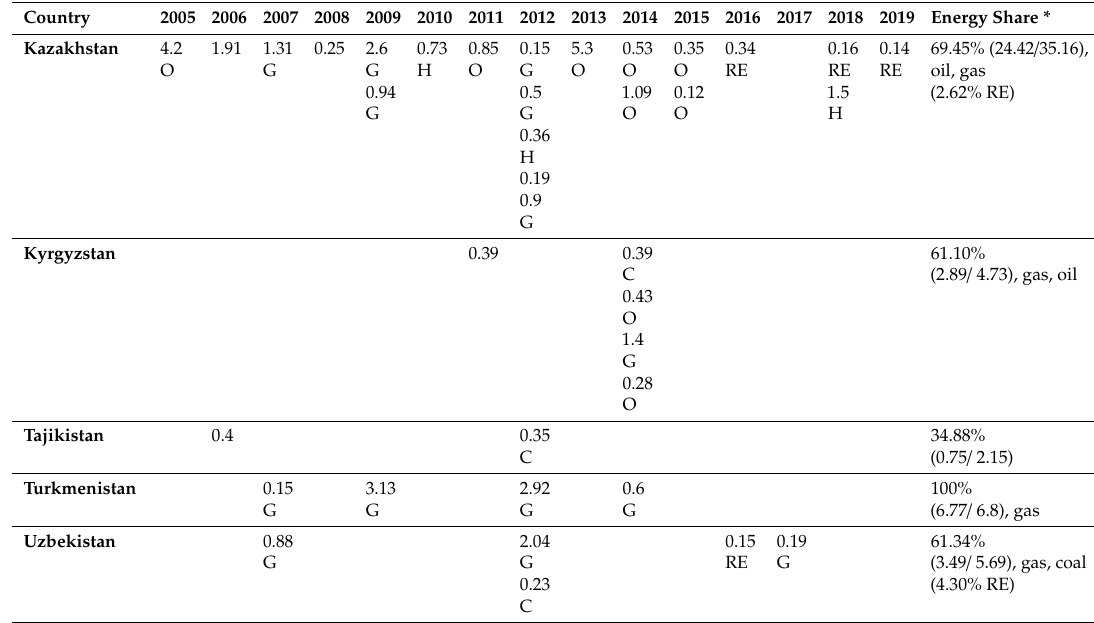
Table A6. China’s Investments in Central Asian Economies’ Energy Sectors, bn US$. (Source: author, based on China Global Investment Tracker and https: // renewablesnow.com / country / kazakhstan-569 / #, https: // renewablesnow.com / news / search / ?term = &sections = all&date = all&country =